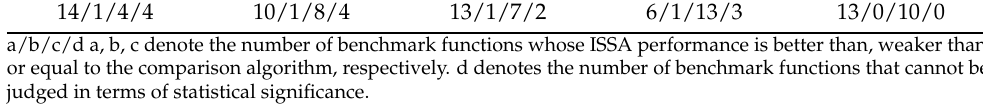
Table 3. Statistical results of the performance advantages and disadvantages between ISSA and each algorithm. ISSA and ISSA and HHO ISSA and GTO ISSA and SSA ISSA and PSO Gold-SA 14/1/4/4 10/1/8/4 13/1/7/2 6/1/13/3